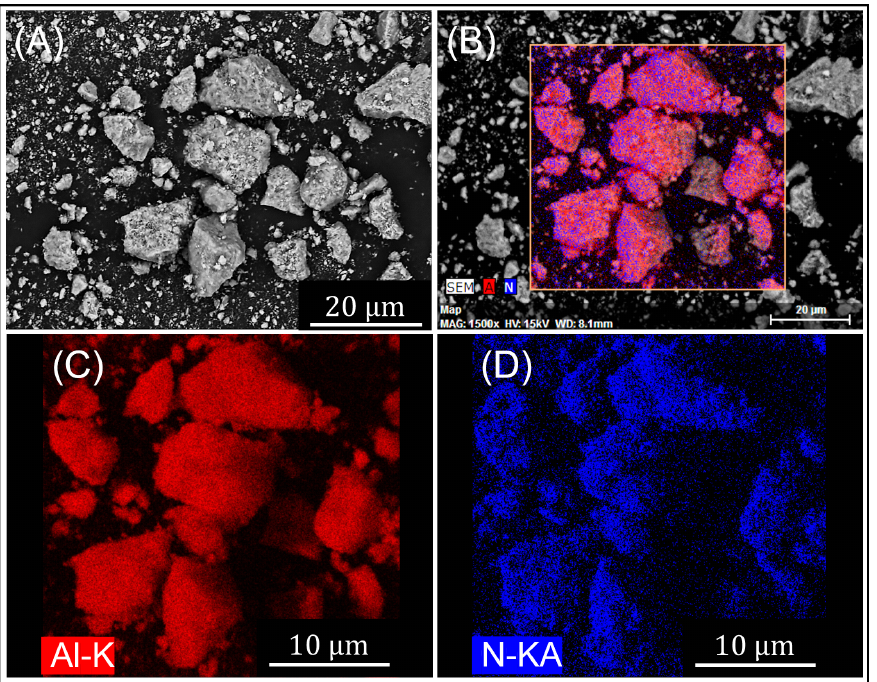
Figure 10. SEM micrograph and EDS mapping of final AlN containing powder nitrided at 520 °C for 6 h, hand milled and sieved at 63 µ m: ( A ) SEM image of processed powder, ( B ) EDS map scan region detecting Al and N, ( C ) EDS map Al-K and ( D ) EDS map